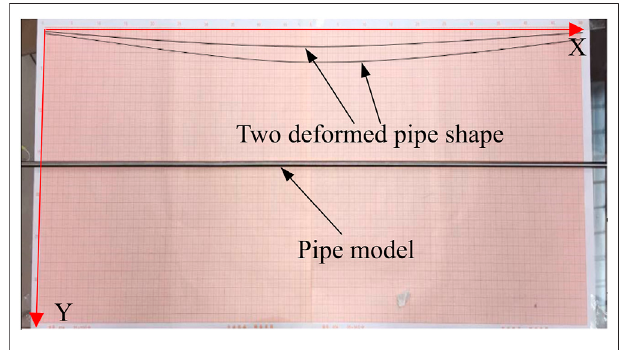
FIGURE 4 | Deformation curve of the pipe model subjected to concentrated